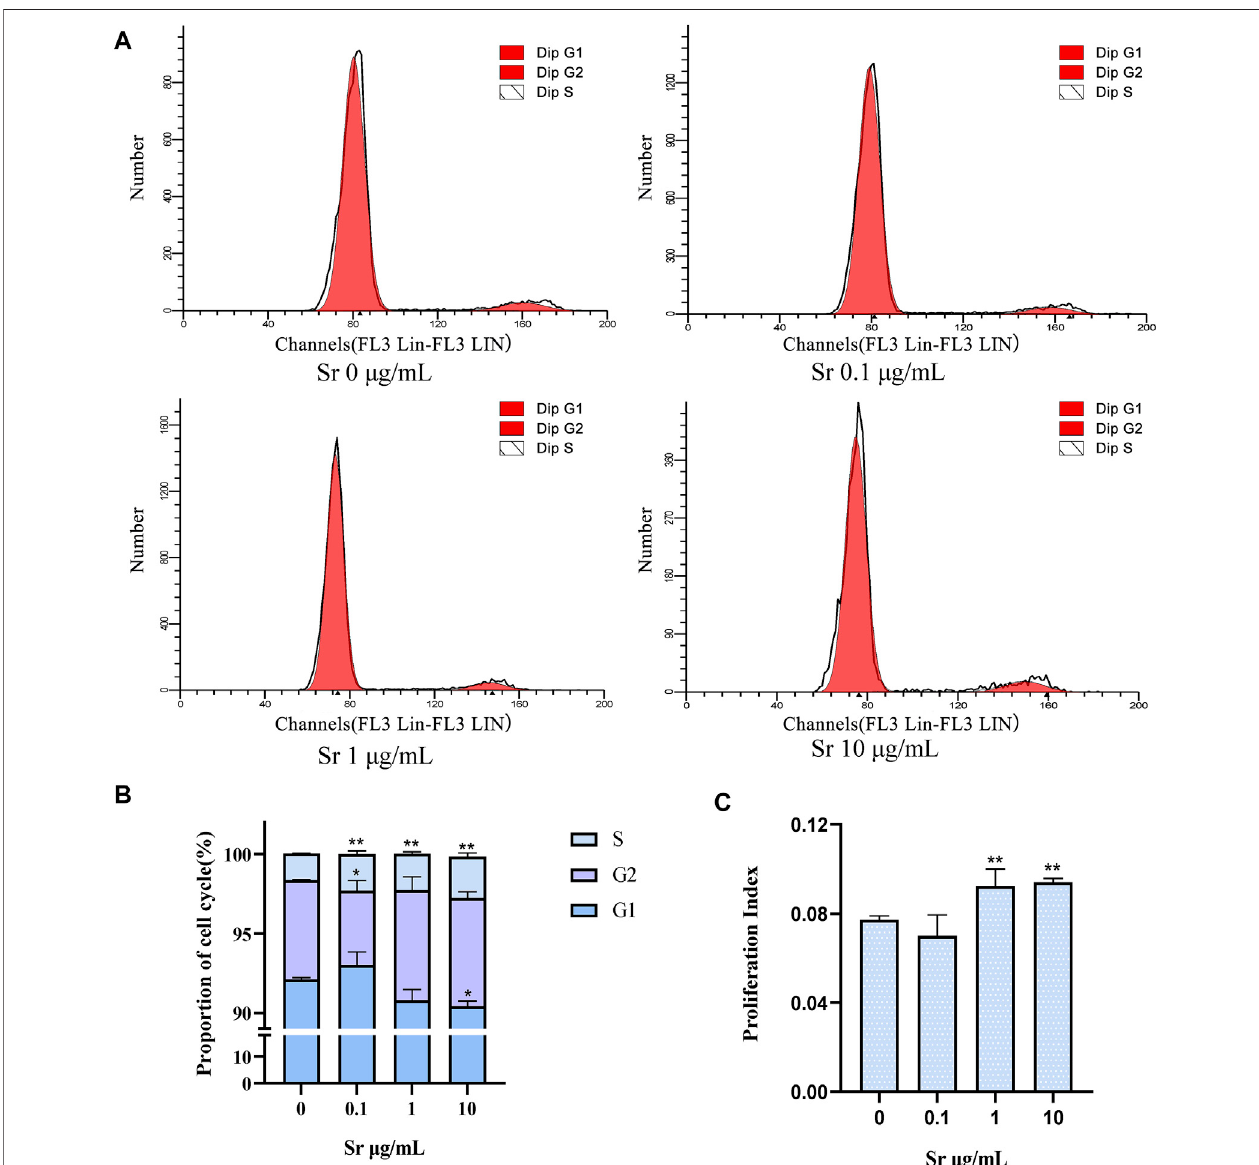
FIGURE 4 | Cell cycle changes in bovine chondrocytes treated with different doses of Sr (0, 0.1, 1, 10 μ g/mL). (A) Representative histograms of fl ow cytometry analysis of the cell cycle in bovine chondrocytes. (B) Representative images of cell cycle distribution. (C) Proliferation index (PI) was calculated based on the equation: PI = (S + G2/M)/(S + G2/M + G0/G1). Data are means ± SEM ( n = 3 in each group) * p < 0.05; ** p <